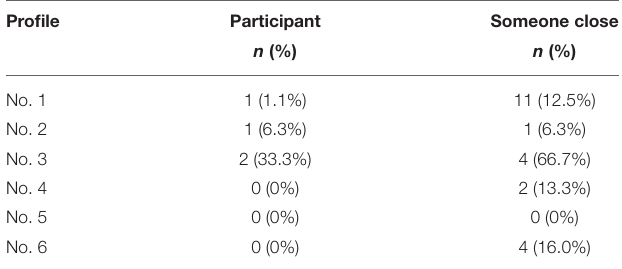
TABLE 5 | Number of participants diagnosed with mental disorders or in a relationship with someone diagnosed with a mental disorder depending on the profile of perceived